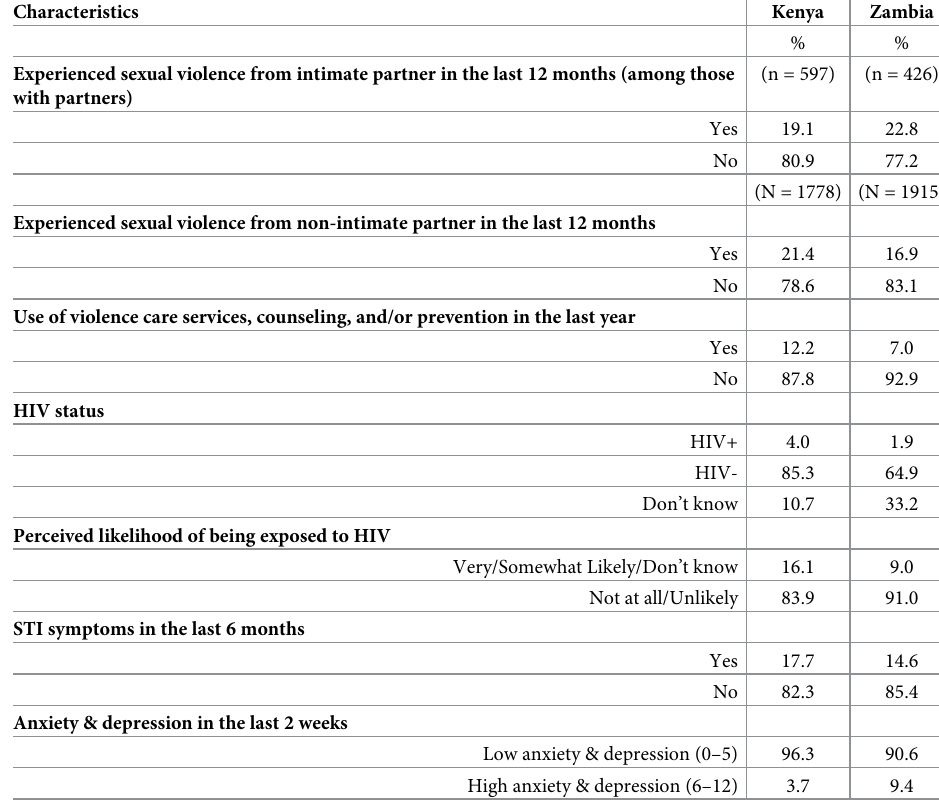
Table 2. Experience of violence and sexual and mental health outcomes, Kenya and Zambia. Characteristics